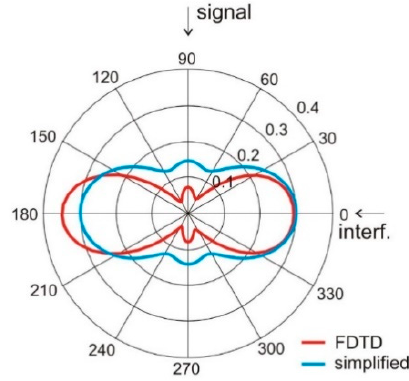
Figure 5. The radiation pattern of the wearable antenna array obtained with FDTD based simulations and the cylindrical model of the body compared to results obtained with the simplified model given by Equation (2) for various values of G 0 .